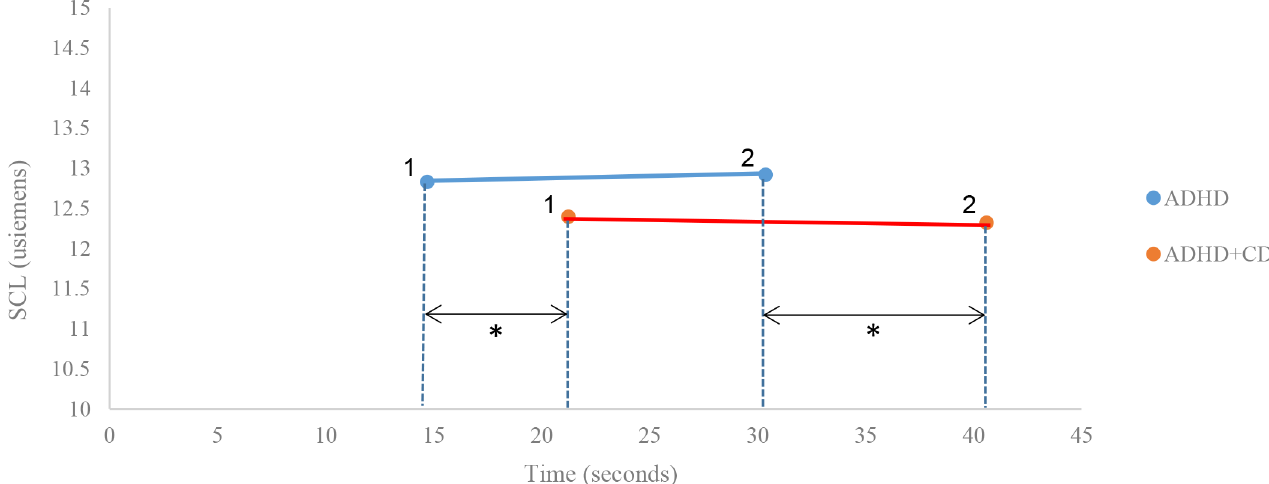
Fig 1. Mean skin conductance level at threshold and tolerance time for the ADHD and ADHD+CD groups. 1 = threshold time; 2 = tolerance time; * = p <